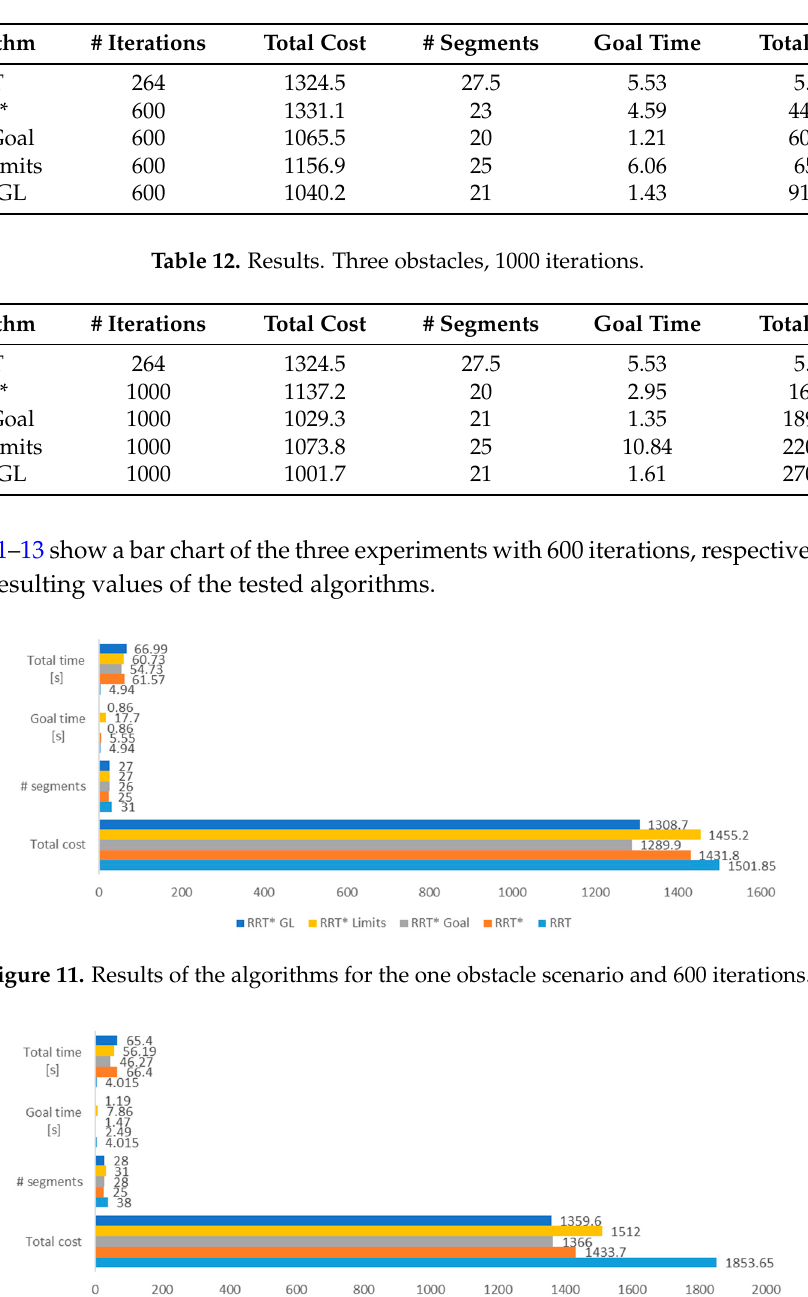
Figure 13. Results of the algorithms for the three obstacles scenario and 600 iterations.